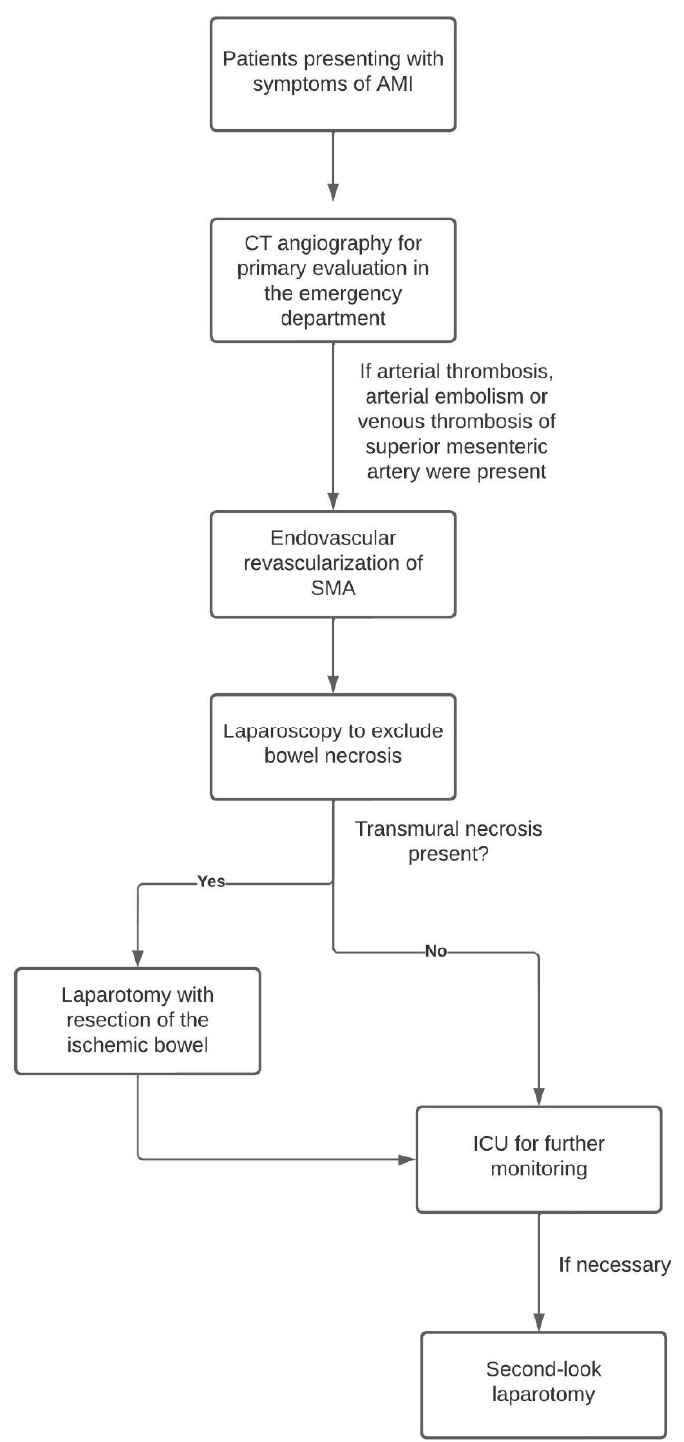
Figure 1. In-house procedure of treatment in patients presenting with AMI.